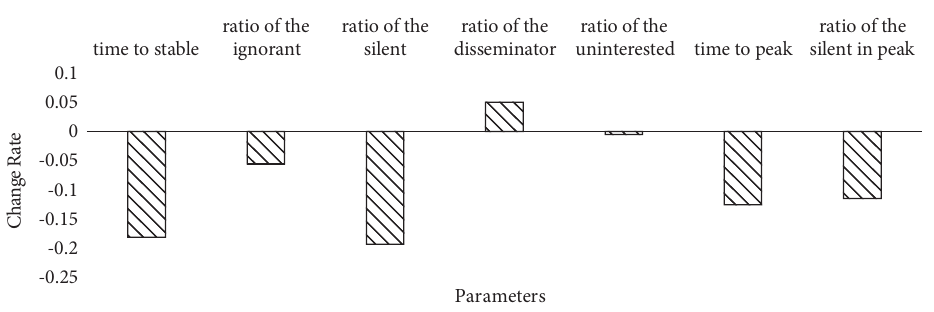
Figure 7: Impact of stigmatization on parameters in the system.